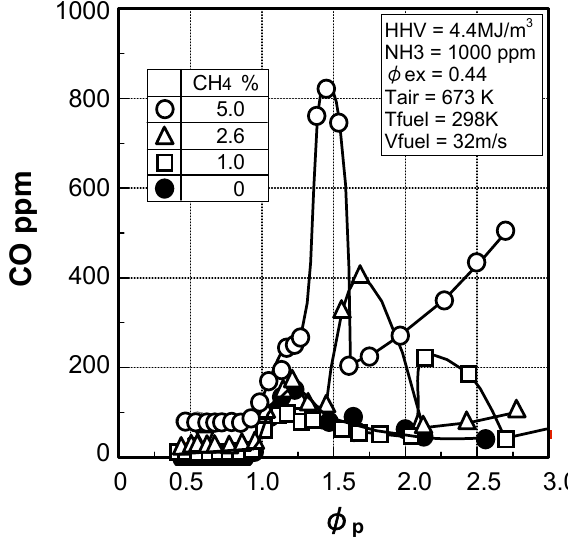
Figure 20. Effect of CH concentration on CO emission characteristics in two-stage 4 combustion defining by